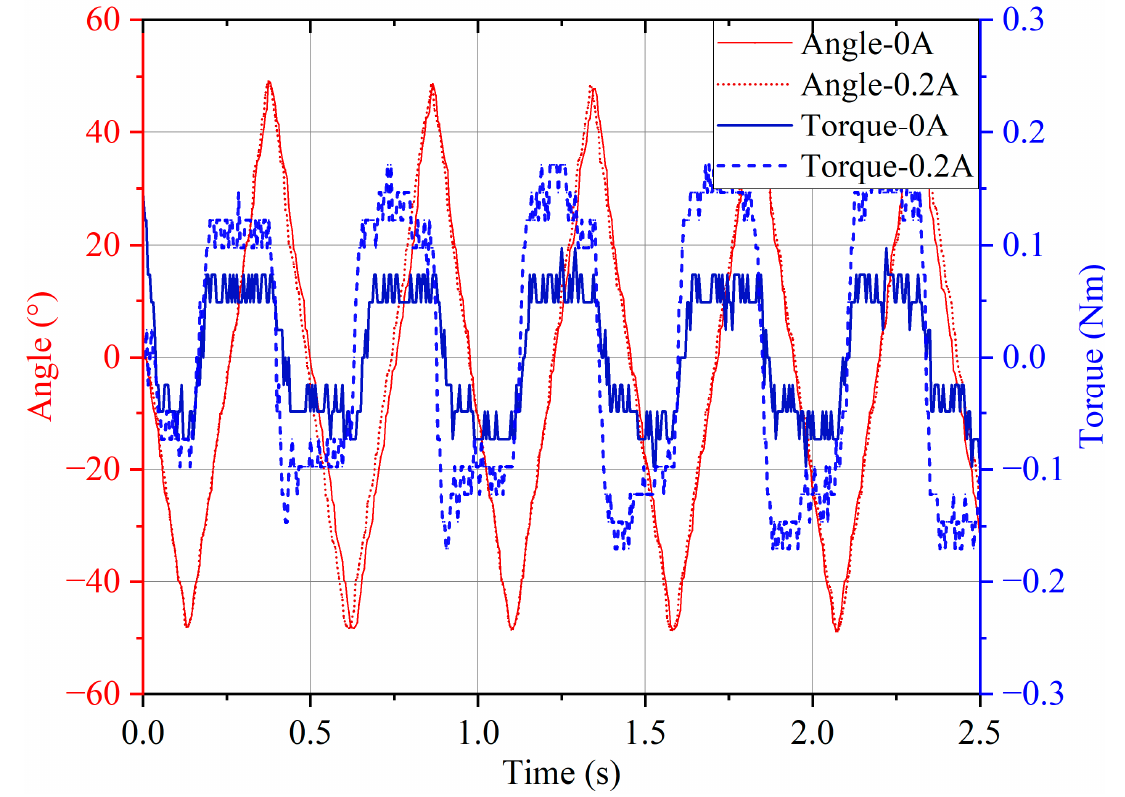
Figure 7. Dynamic time-domain signal of torque and rotational angle. The sampling frequencies of the current and torque signals are both 200 Hz. Figure 7 indicates the relationship between the rotational angle and the torque. The amplitude of the angle was nearly 50 ◦ . The speed was nearly constant in the experiments, while the direction changed periodically. In each period, the torque changed abruptly when the rotating direction reversed. The torque remained much steadier during the rest of the period. The MR damper was tested at different currents in the coil. Figure 8 shows the variation in torque–angle loops under different currents. In general, the maximum torque and the energy dissipated per cycle increased simultaneously as the current rose. When